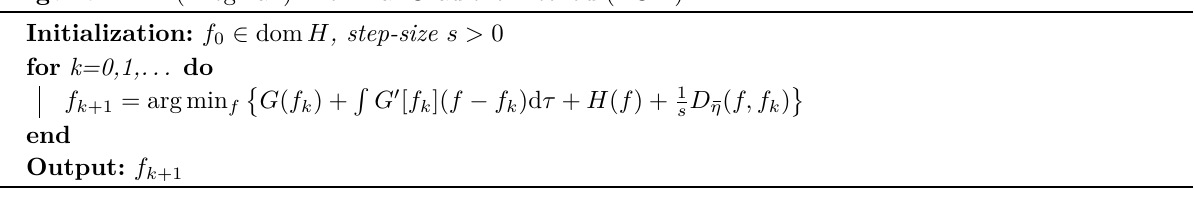
Algorithm 1: (Bregman) Proximal Gradient Method (PGM)